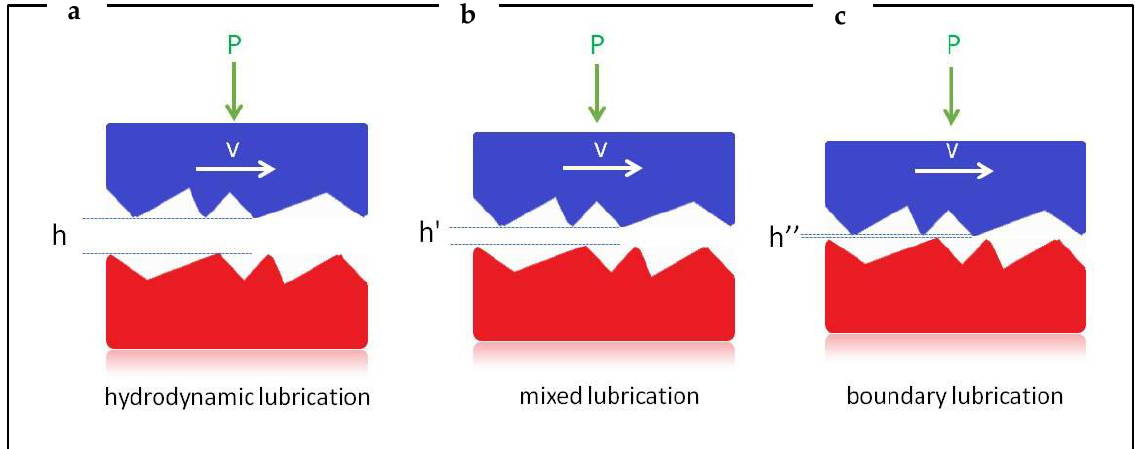
Figure 5. Representation of the main mechanisms of lubrication: ( a ) boundary lubrication, ( b ) mixed lubrication, and ( c ) hydrodynamic lubrication. P: pressure; V: velocity.